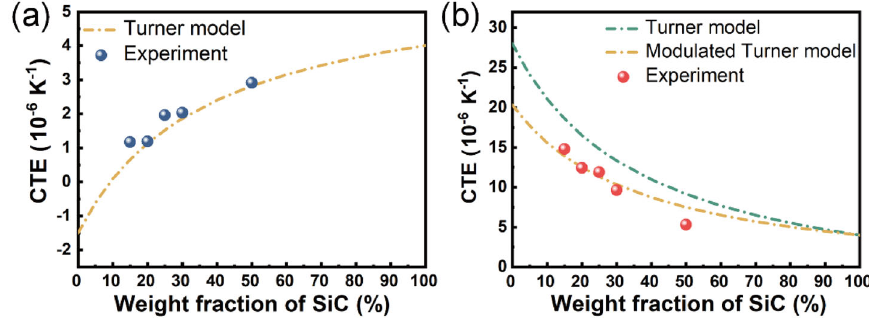
Fig. 11 Measured and calculated CTE values of the composites in (a) x – y plane and (b) z axis directions. The curves are the modeling